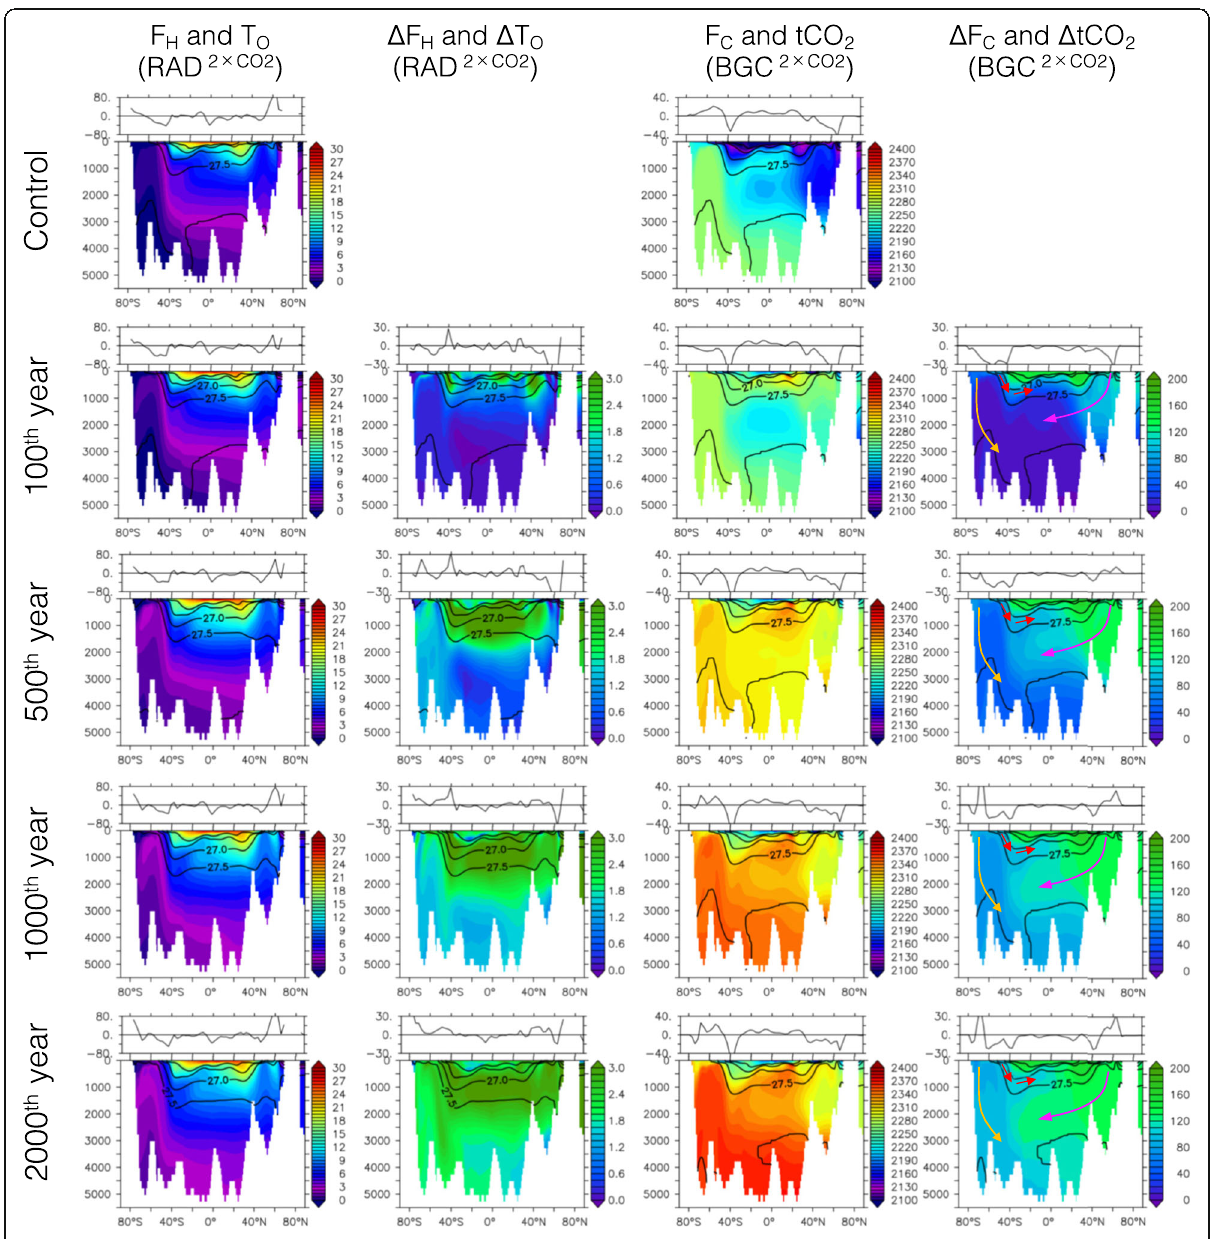
Fig. 7 Atmosphere-ocean heat and carbon dioxide (CO 2 ) fluxes (plots) and vertical distributions of ocean temperature and dissolved inorganic carbon (DIC) (T O and tCO 2 ; shades) in the Atlantic ocean (30°W): the first and third columns show the absolute magnitudes of the fluxes and system states (ocean temperature and DIC), and the second and fourth columns show the anomalies from the control run. The units are: W m − 2 for ocean net heat flux (F H ; negative means ocean uptake), °C for T O , gC m − 2 year − 1 for ocean net carbon flux (F C ; negative means ocean uptake), and mmol m − 3 for tCO 2 . Counter lines in panels show isopycnic surfaces with an interval of 0.5 σ θ . The RAD 2 × CO2 result by MIROC-ESM is used for the F H and T O analyses, and BGC 2 × CO2 for F C and tCO 2 . All analyses were made based on 30 year averages and anomalies. Red, orange, and magenta arrows represent the anthropogenic C transport by the Antarctic intermediate water (AAIW), Antarctic bottom water (AABW), and North Atlantic deep water (NADW),